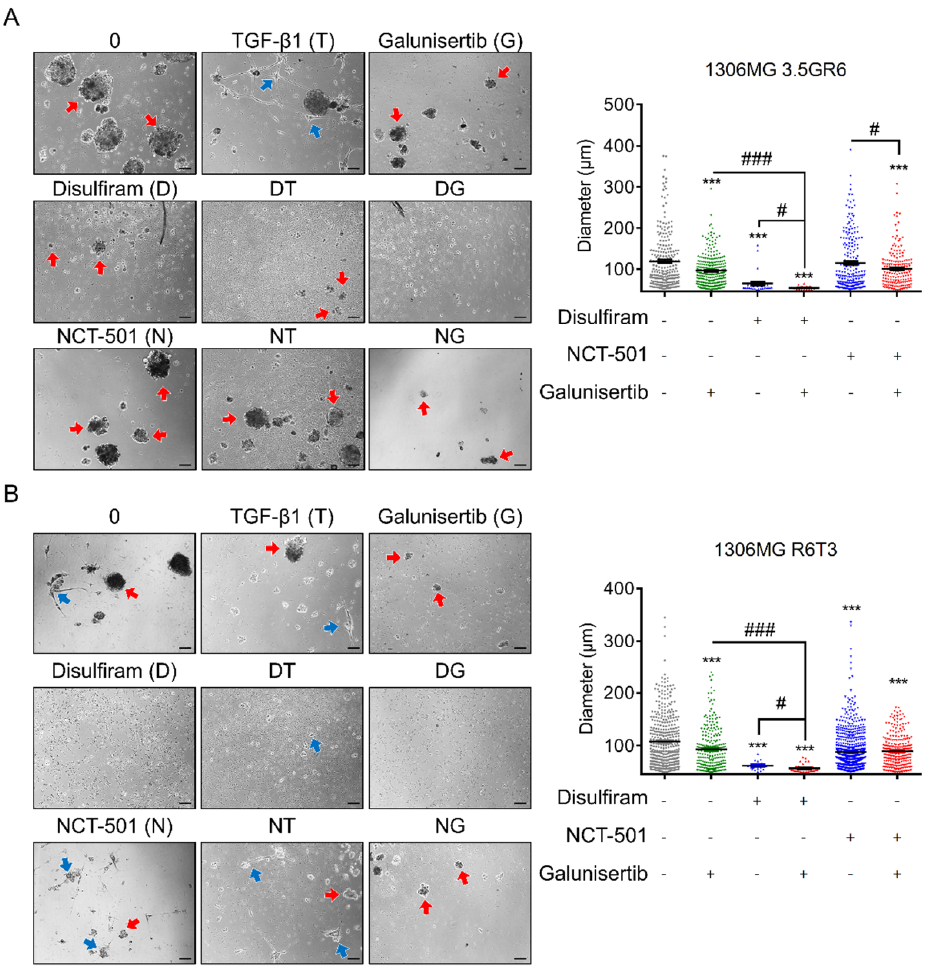
Figure 7. Combining ALDH inhibition and Galunisertib restrains the growth of tumor spheres. The 3D tumor sphere formation assay was used to evaluate the inhibitory effects of combining ALDH inhibition and Galunisertib on the growth of tumor spheres. The lengths of the tumor spheres were calculated. The “ + ” means with the treatment while the “ - ” means without the treatment. ( A ) Graphs and histogram showing the ability of radiation-resistant 1306MG 3.5GR6 to form tumor spheres; ( B ) graphs and histogram showing indicating the ability of radiation-TMZ-resistant 1306MG R6T3 to form tumor spheres; the red arrows indicate the tumor spheres; the blue arrows indicate the cells with the growth of processes; scale bar = 100 μm; mean ± SEM; * refers to a comparison with the control; # refers to a comparison with sole Galunisertib or DSF or NCT-501; * and #, p < 0.05; *** and ###, p < 0.001.